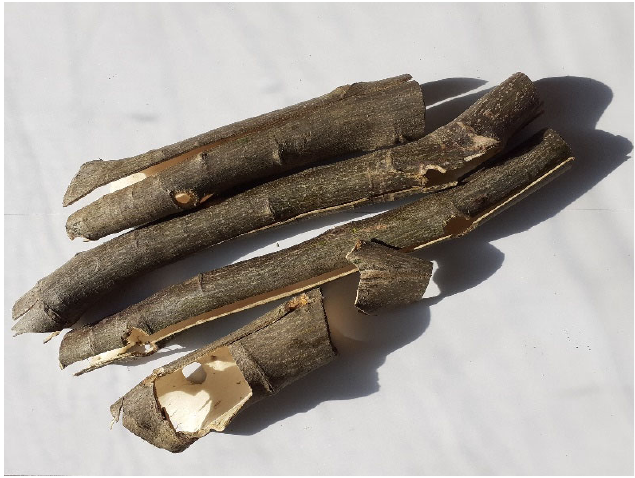
Figure 1. The raw material for testing after pre ‐ drying process.